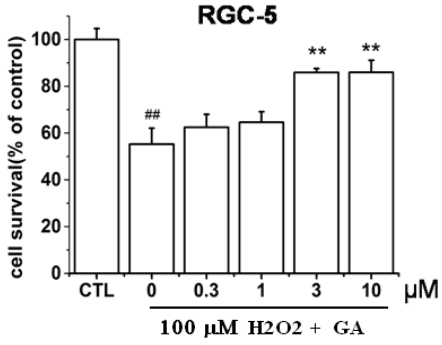
Figure 2. Protective effects of GA on RGC-5 cells death induced by H 2 O 2 . Cells were treated with di ff erent concentrations of GA and were exposed to 100 µM H 2 O 2 . The cell viability was determined by MTT assay. ## p < 0.01 vs. control; ** p < 0.01 vs. model ( n =